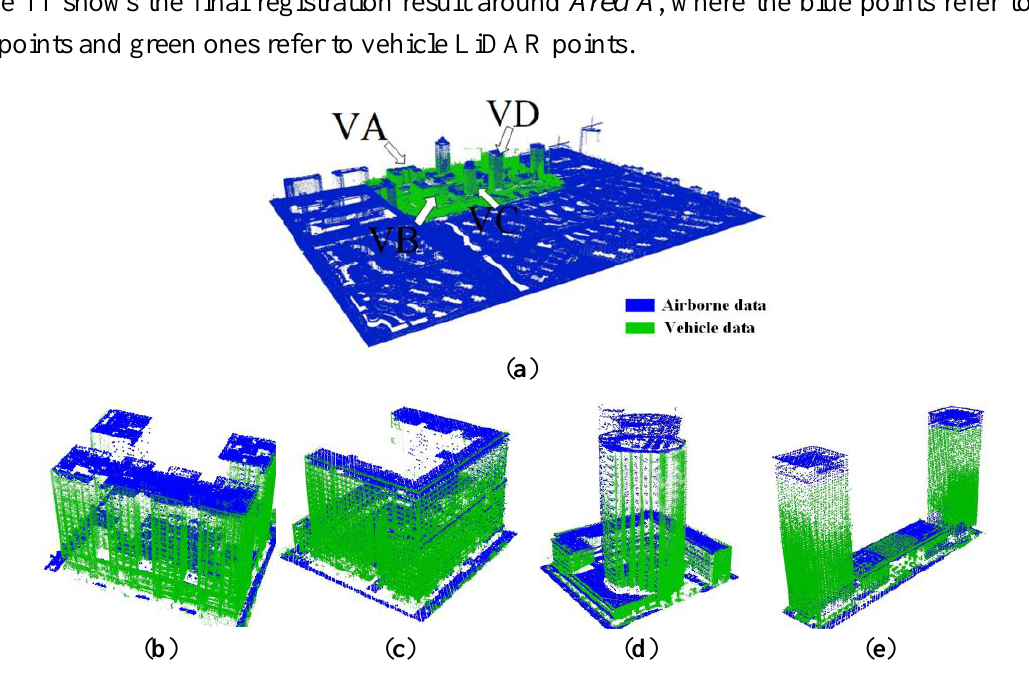
Figure 11. Registration result of Area A using the proposed method. ( a ) Registration result in Area A ; ( b ) Details of VA ; ( c ) Details of VB ; ( d ) Details of VC ; ( e ) Details of